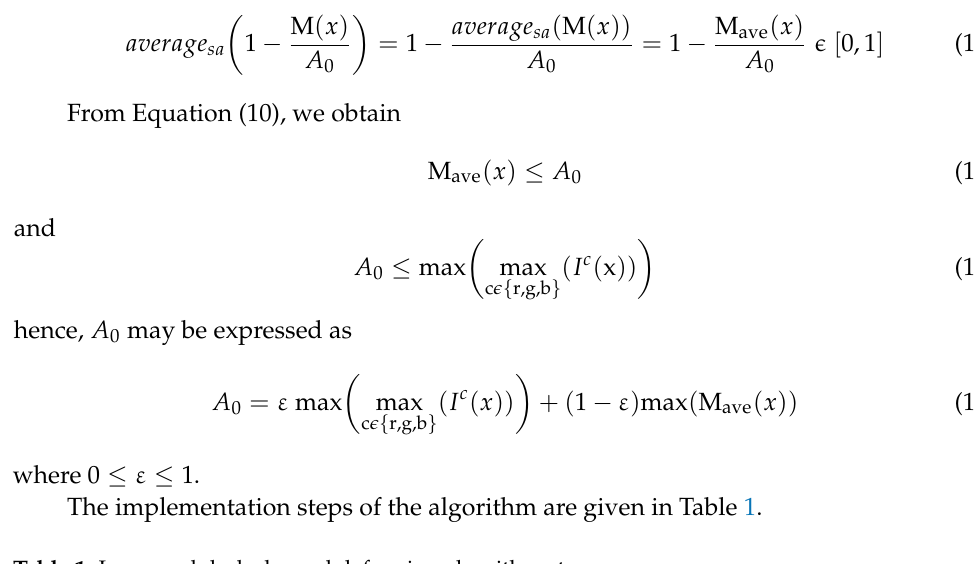
Table 1. Improved dark channel defogging algorithm